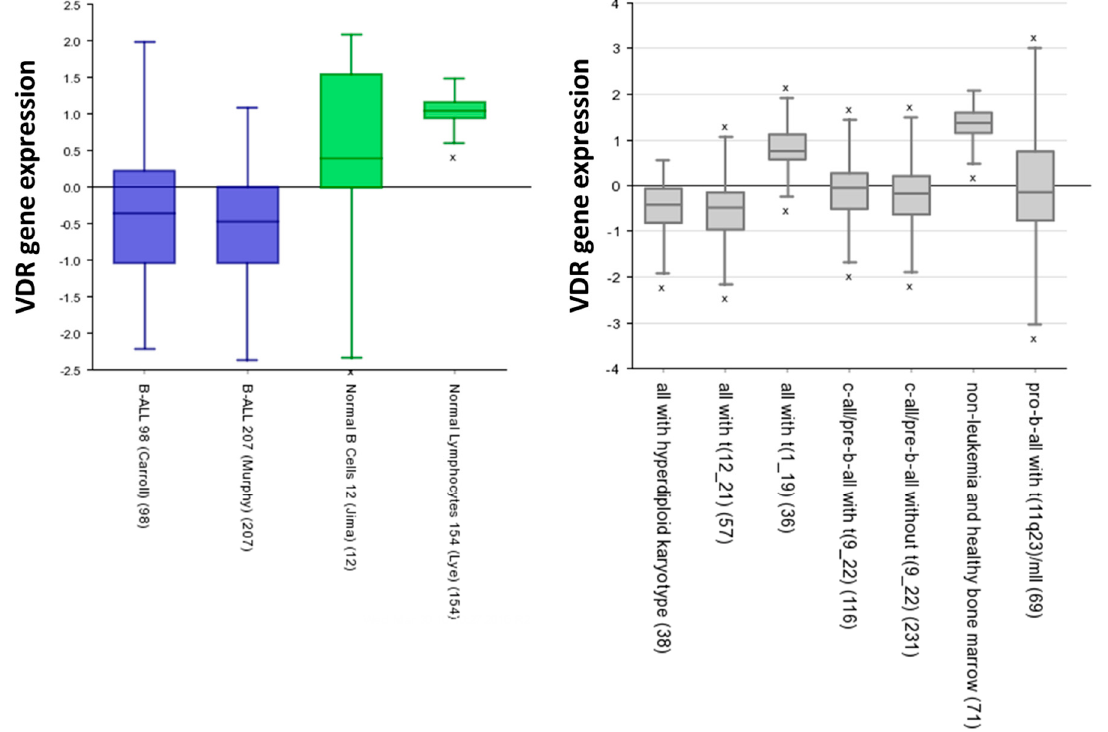
Figure 3. VDR expression is lower in human LSCs than in normal B cells. Using the R2 (http://r2.amc.nl) Genomics analysis and visualization platform [49] we analyzed VDR gene expression in human leukemic cells and in normal B cells from different datasets available in the platform. The expression values are represented in a transform z-score. The VDR Probeset used was 204254_s_at. “x” represents outlier.